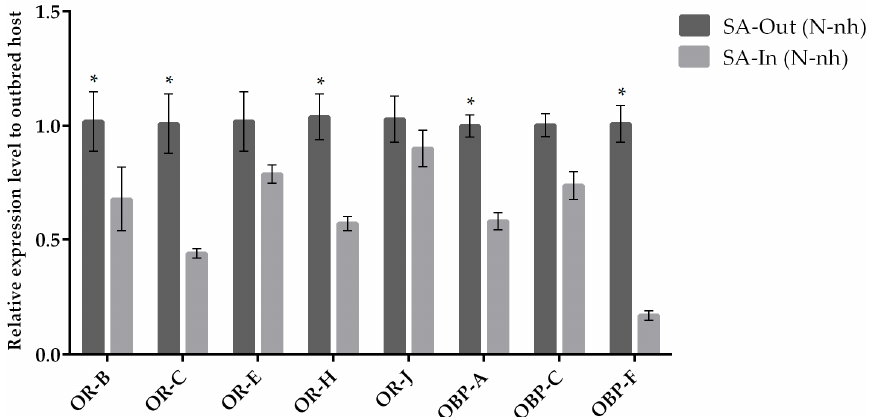
Figure 6. Mean ( +/ − SE) expression levels of ORs and OBPs from the heads of outbred (SA-exogamic) and inbred (SA-endogamic) A. ervi transplanted from the natal host A. pisum onto the non-natal host S. avenae (SA), measured by RT-qPCR. RT-qPCRs were performed using specific primers for each gene. Normalizer gene: RPL19. The asterisk * above the bars indicates significant di ff erences according to two-way ANOVA ( p value <